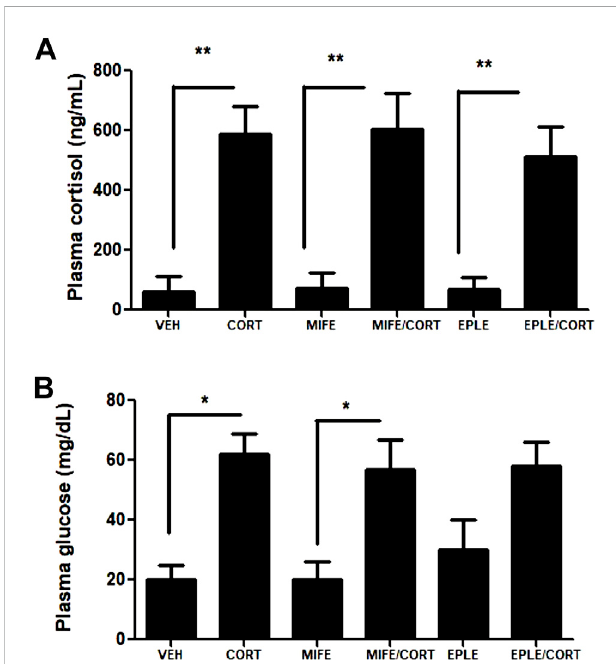
FIGURE 1 Plasmacortisolandglucoselevelsofrainbowtrout.Cortisol (A) and glucose (B) levels were measured in the plasma of fi sh intraperitoneally treated with vehicle (VEH), cortisol (CORT), mifepristone (MIFE), eplerenone (EPLE), mifepristone plus cortisol (MIFE/CORT), eplerenone plus cortisol (EPLE/CORT). The results are expressed as a mean ± SEM, ( n = 4). The “ * ” ( p < .05) and “ ** ” ( p < .01) represent signi fi cant differences compared with the vehicle, mifepristone, eplerenone